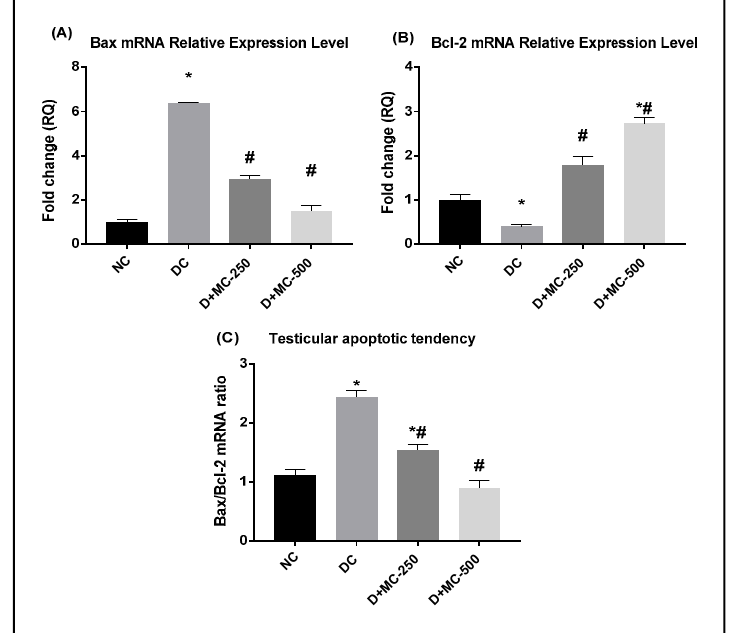
Figure 6. Effect of Momordica charantia (MC) extract against mitochondria-associated apoptotic cell death in testes of STZ-induced diabetic rats was examined by real-time RT-PCR: ( A ) relative Bax mRNA expression, ( B ) relative Bcl-2 mRNA expression, and ( C ) Bax mRNA to Bcl-2 mRNA ratio (Bax/Bcl-2). Data are presented as mean ± SEM.* Significantly different from NC group; # significantly different from DC group.